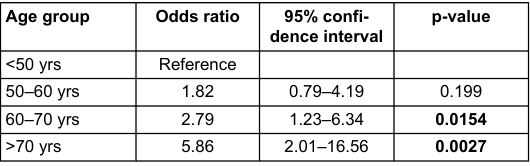
Table 5: Odds ratios for urinary tract infection by age group.